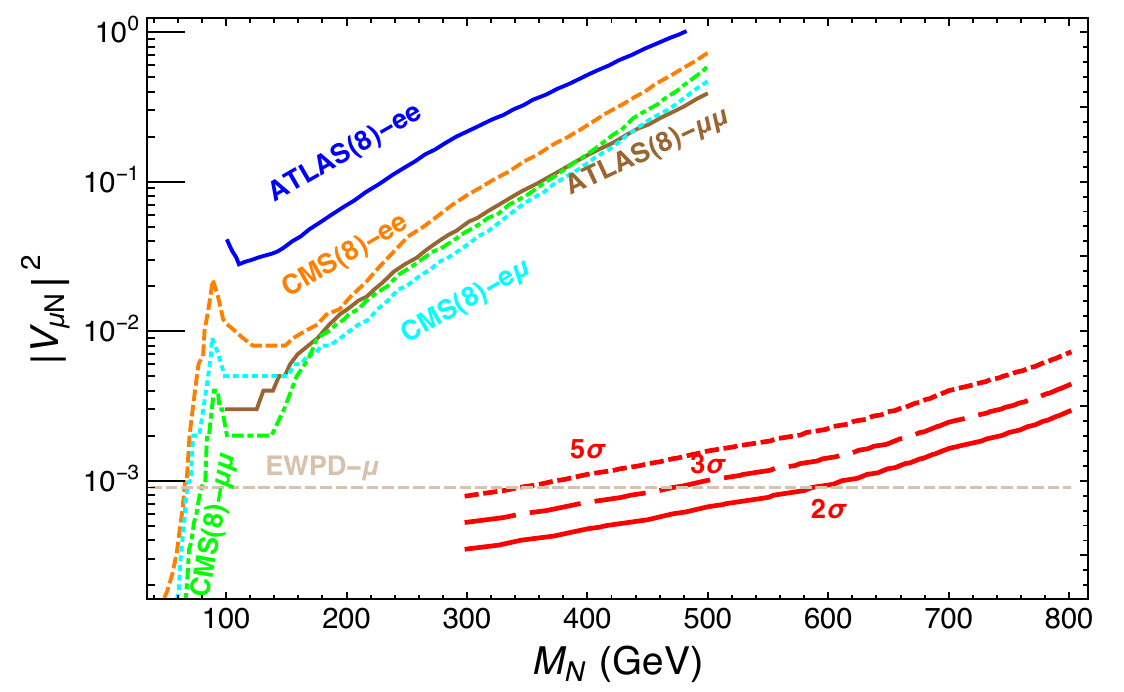
2 at the 13 TeV LHC V (cid:22)N j j